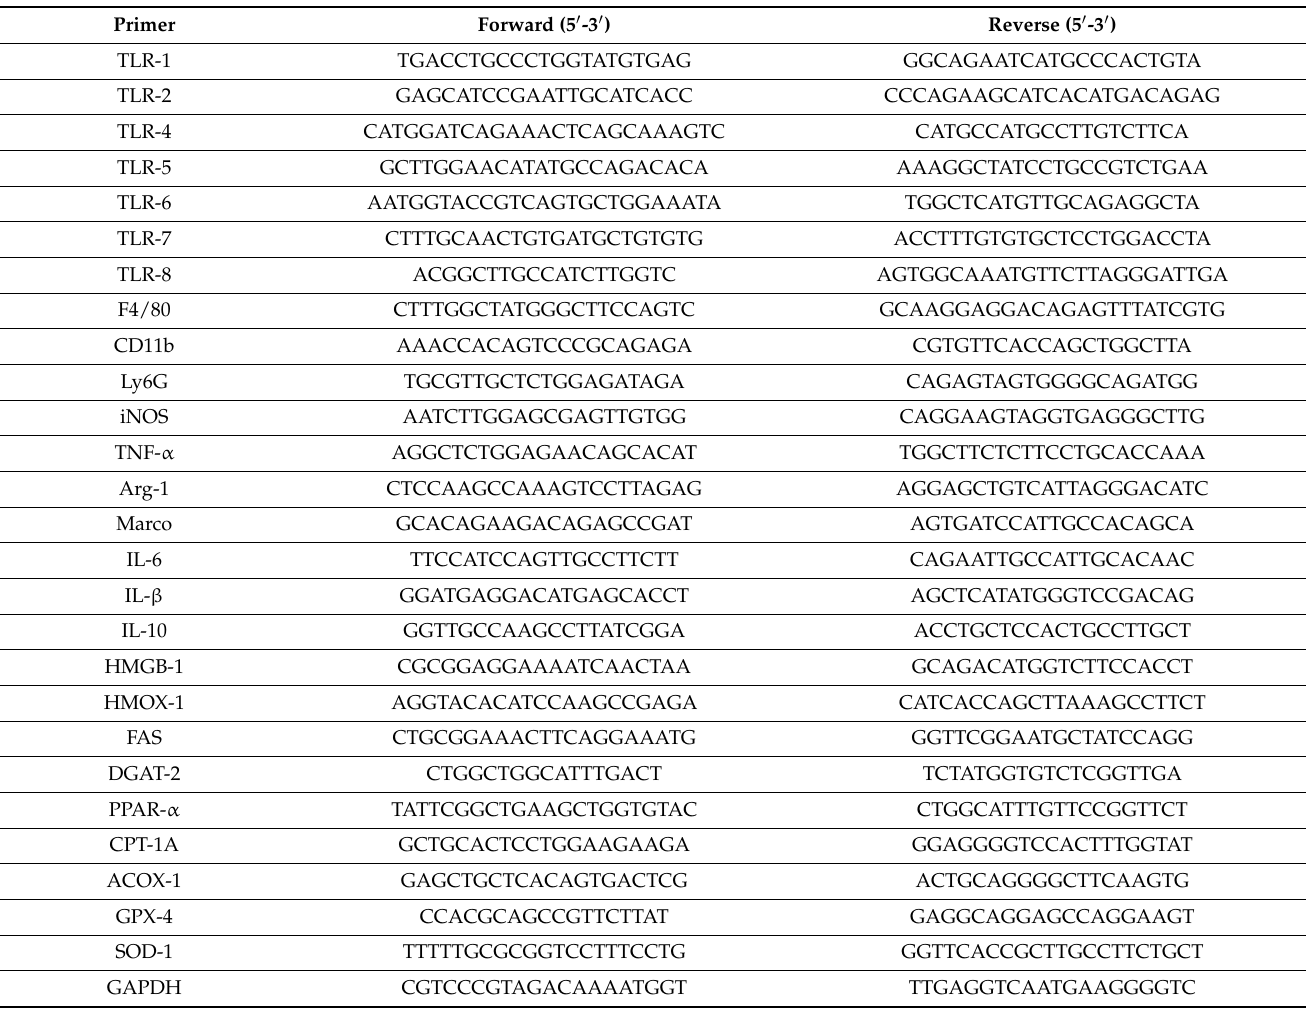
Table 1. Primer sequences used for